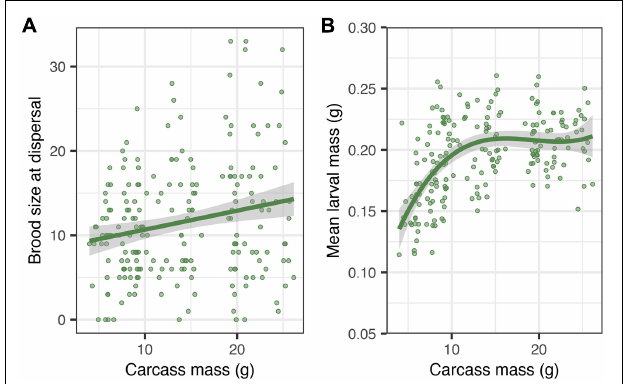
FIGURE 4 | Effects of carcass mass on brood size at dispersal (A) and mean larval mass at dispersal (B) . Filled circles represent individual data points; lines represent a linear regression line in panel (A) and a polynomial regression line in panel (B) , and shaded ribbons the 95% confidence